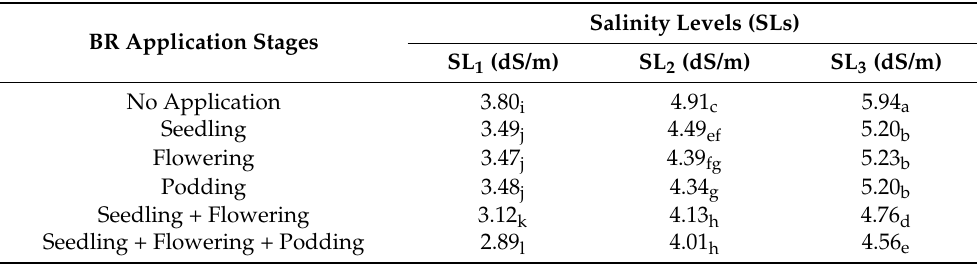
Table 3. Interaction effects of growth stages of 24-epibrassinolide application (BR) and salinity levels (SLs) on electrical conductivity of saturated soil extracts (EC se s, dS/m) in soybean rhizosphere.